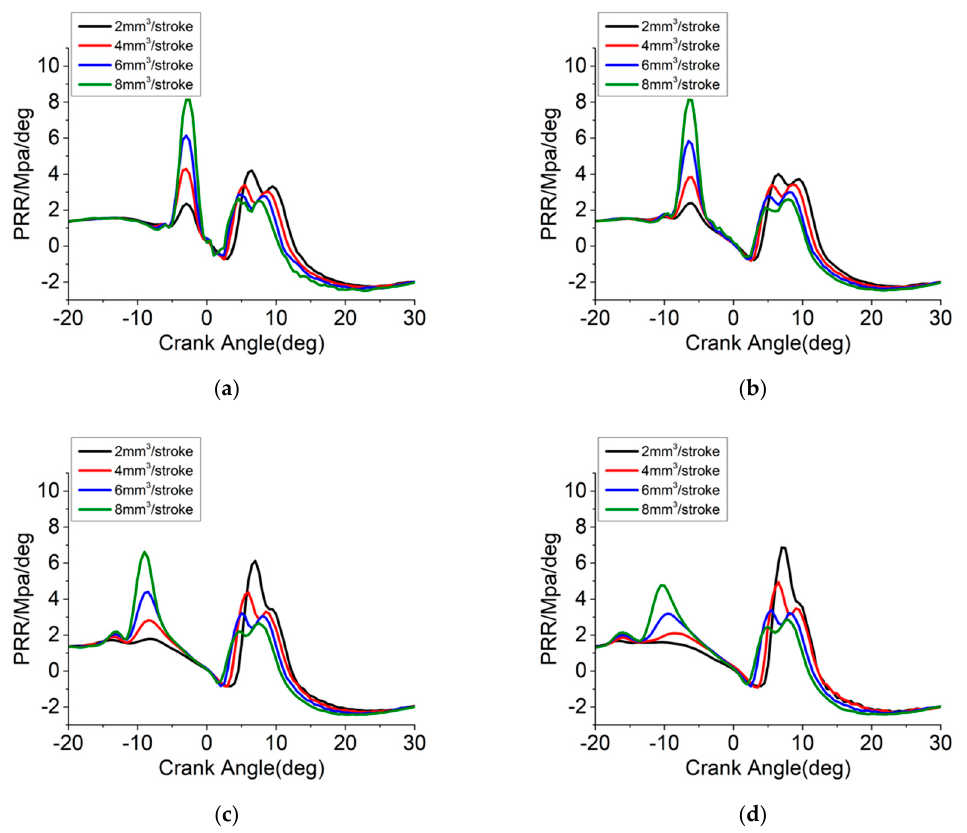
Figure 3. In-cylinder pressure rise rates. ( a ) Pilot injection timing = − 9°ATDC; ( b ) pilot injection timing = − 14° ATDC; ( c ) pilot injection timing = − 19° ATDC; ( d ) pilot injection timing = − 24° ATDC.